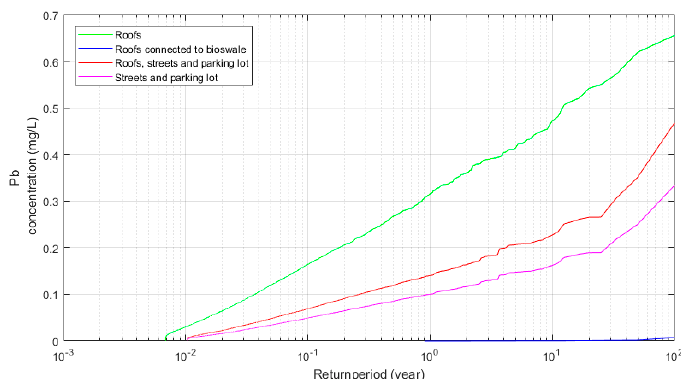
Figure 3. Example of the output of the aquaSens tool for the lead concentration in runoff water for a catchment with roofs, a street, and a parking lot.